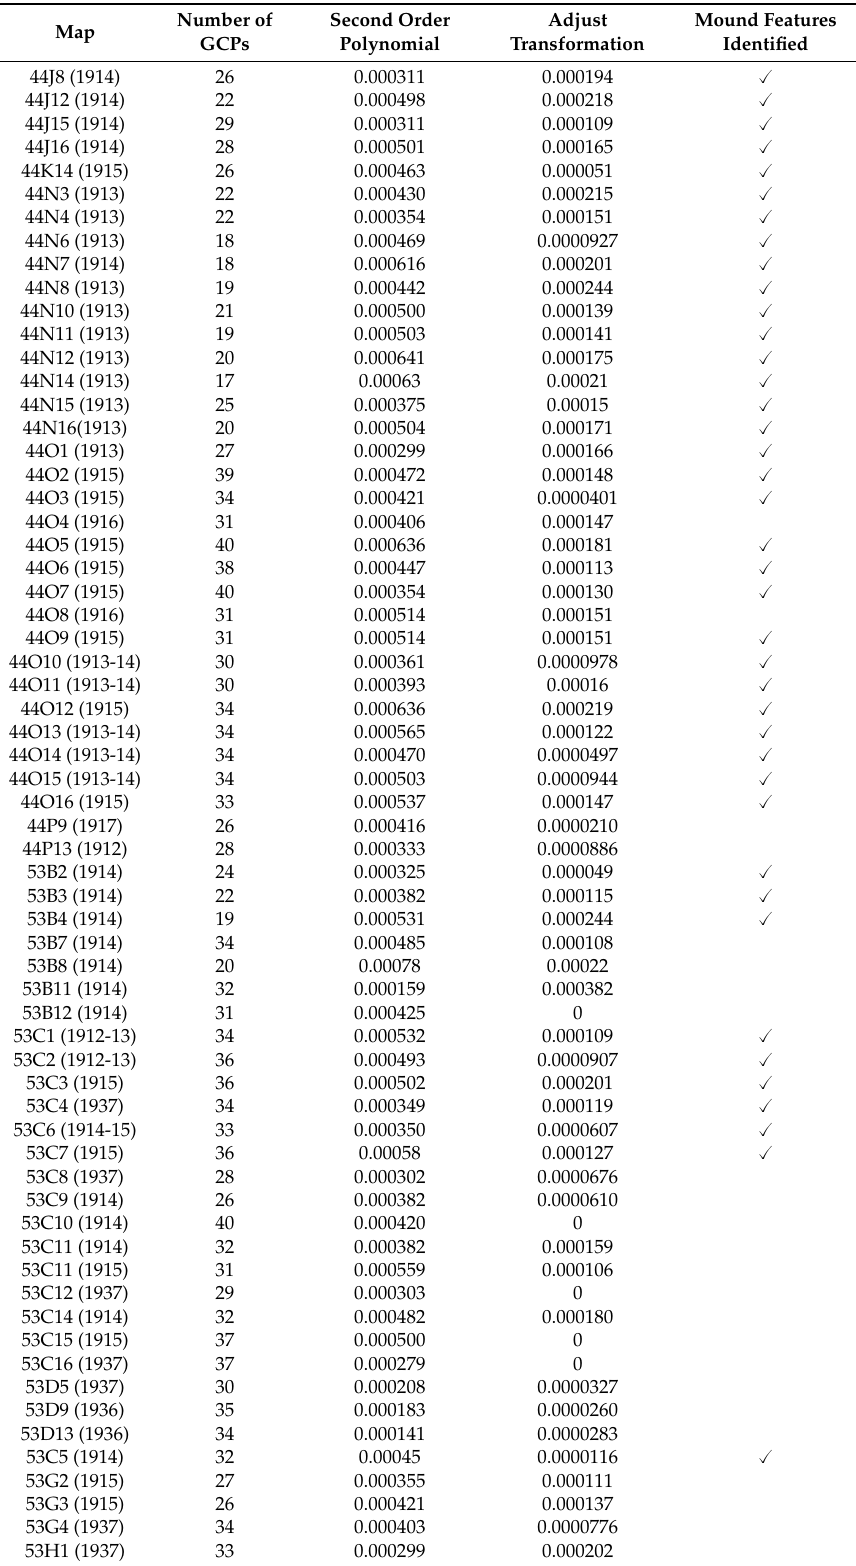
Table 1. Calculation of the root mean square error for a selection of georeferenced Survey of India 1” to 1-mile maps using second order polynomials and the Adjust transformation. GCPs: ground control